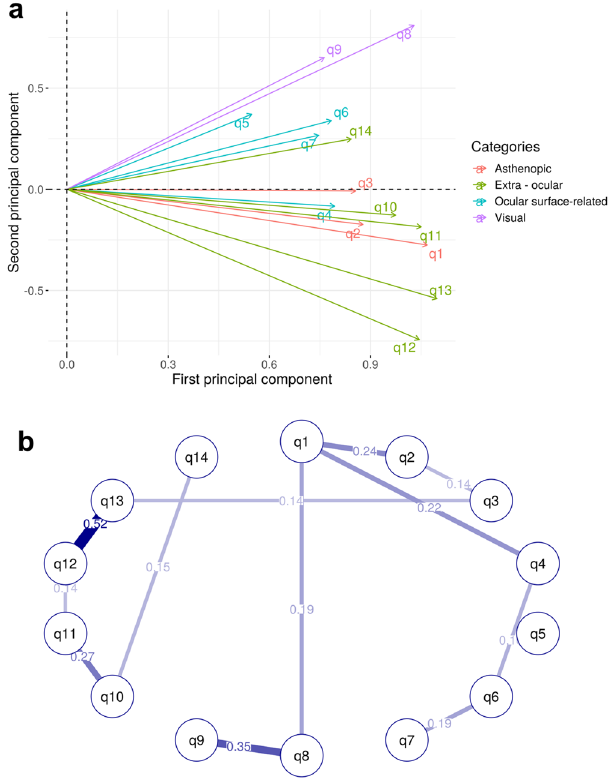
Figure 1. ( a ) PCA results for questionnaire items based on the partial correlation matrix. The length of arrows indicates contributions of the variables to the principal axes. The proportion of variance captured is given as a percentage for both the first and second principal components. ( b ) Partial correlation network estimated by covariance selection. A dense subnetwork of high partial correlated edges is called a clique, and the existence of a clique would suggest the presence of the same number of latent factors. No cliques with edges all having values greater than 0.2 were found in the network. For model optimization, gmm package (ver. 1.6-5) in R was used to minimize Akaike information